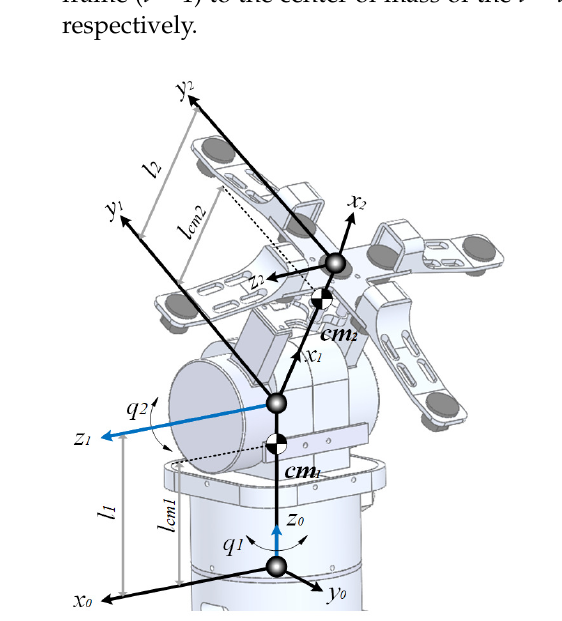
Figure 2. Schematic of the robotic